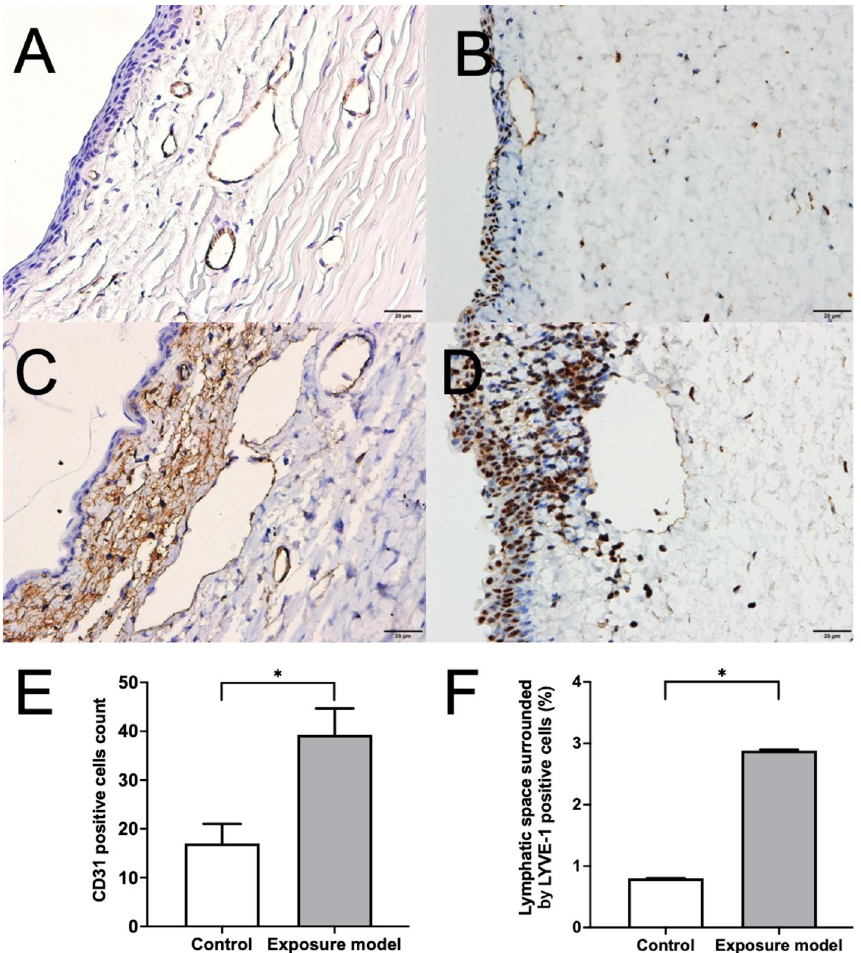
Figure 5. Immunohistochemistry of CD31 ( A , C ) and LYVE-1 ( B , D ) in serial sections of the conjunctiva of control ( A , B ) and exposure rabbit model ( C , D ). Comparisons of the number of CD31-positive cells ( E ) and the lymphatic space surrounded by LYVE-1-positive cells ( F ) between control and exposure model rabbits. Number of CD31-positive cells and the lymphatic space surrounded by LYVE-1-positive cells were significantly increased in conjunctival tissue after ocular surface exposure as compared with the control ( p = 0.0006, p < 0.0001, Mann– Whitney U test,